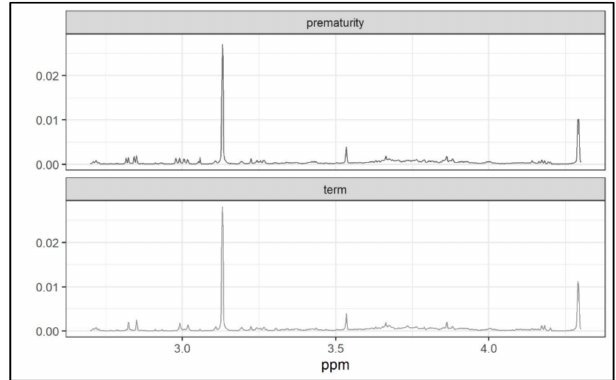
Figure 6. Comparison of mean spectra from each the two groups.